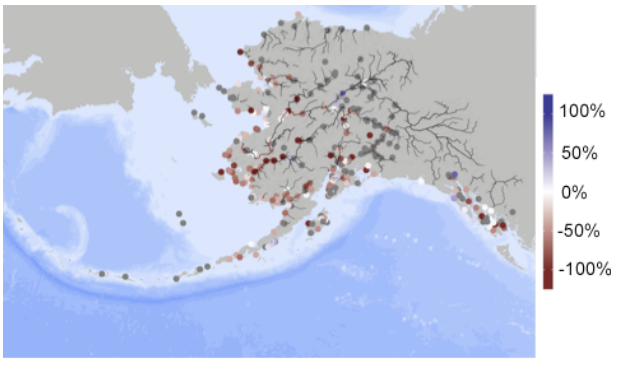
Fig. 4. Change in percentage of number of permits per capita by community (1990–2016) (Clark et al.